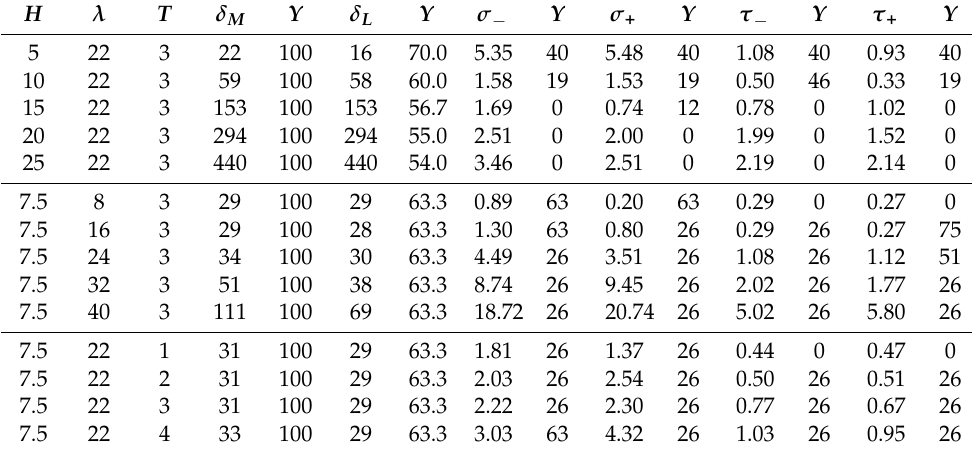
Table 5. Values and positions ( Y = % H from base to top) of maximum deflection ( δ M ) and deflection in the horizontal load ( δ L ) position (mm), maximum negative ( σ − ) and positive ( σ + ) normal stresses (MPa), and maximum negative ( σ − ) and positive ( σ + ) shear stresses (MPa) for the height ( H ), slenderness ( λ ), and taper ( T × 10 2 ) values adopted in each of the simulated scenarios. Horizontal load 10 kN.